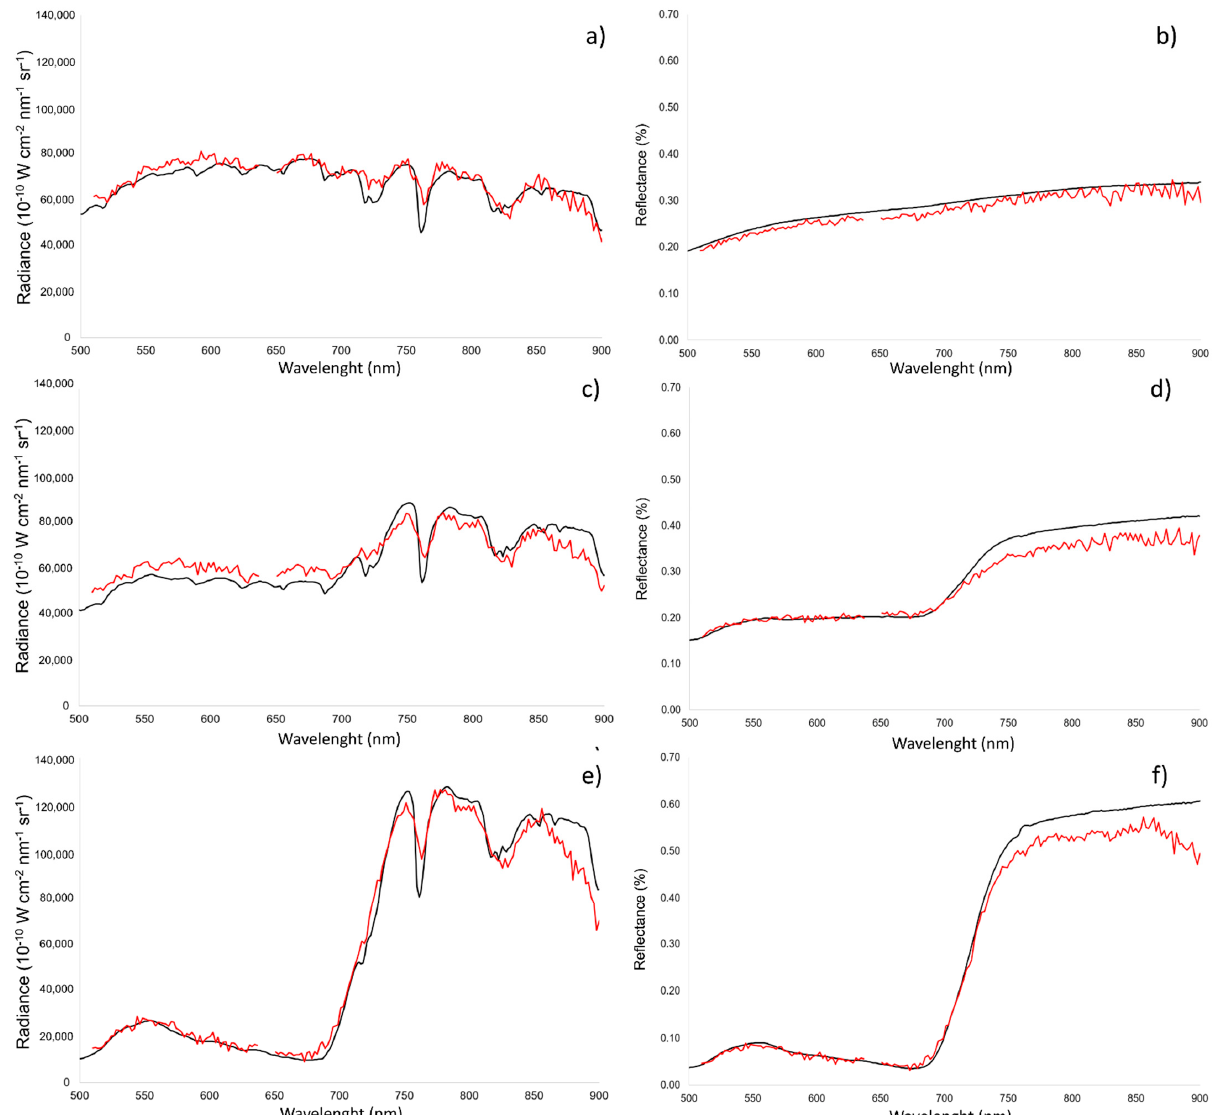
Figure 7. Comparison between GER 3700 (black line) and SENOP HSC-2 (red line) spectral signature in radiance and reflectance of soil with dry grass ( a , b ), soil with grass ( c , d ) and canopy ( e , f ) targets. Firstly, the visual analysis of the spectral signatures extracted from the different tar- gets confirms the ability of the SENOP HSC-2 hyperspectral camera to provide the same spectral trend provided by the GER 3700, in line with what was previously observed by the comparison made on the reference panels. Taking into consideration the absolute val- ues of radiance, a slight overestimation is observed in the visible region (500–700 nm ap- proximately) on all the targets acquired on the ground (Figure 6). As for the signatures containing vegetation (Figure 7), the absolute values are much more in line with the data provided by the GER 3700, and on the canopy Figure 7e shows spectral signatures with highly overlapping values. Taking into consideration high values of radiance greater than 60,000 × 10 − 10 W/cm 2 /nm/sr in the nir region (wavelengths > 800nm), an underestimation was observed mainly on the vegetated targets, which is consequently also found in the reflectance values.